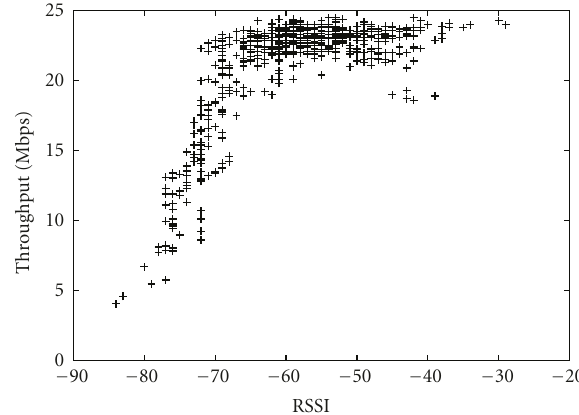
Figure 9: Relation between the obtained bandwidth and the reported RSSI by the 802.11g devices.